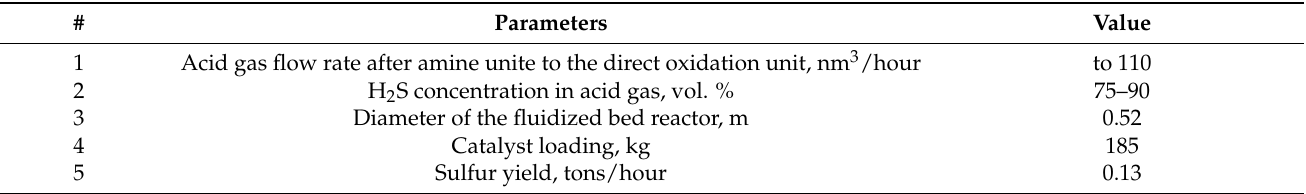
Table 4. Main characteristics of the installation for the removal of H 2 S from gases originating from the blowing off of sour crude oil, designed for JSC